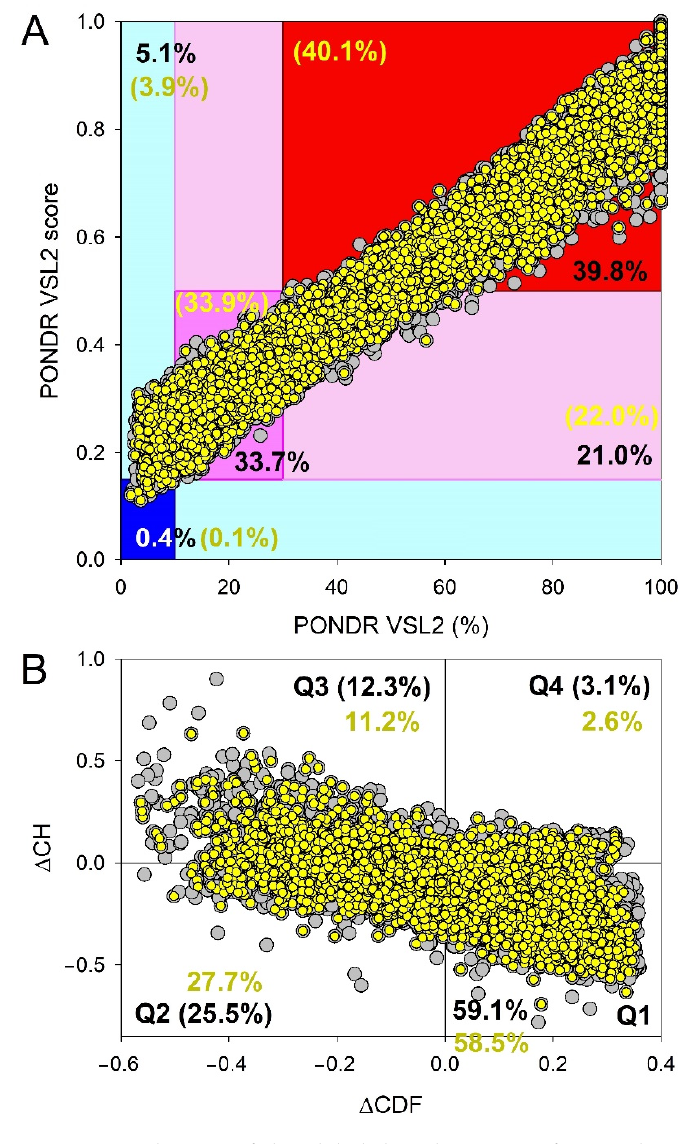
Figure 8. Evaluation of the global disorder status of 20,317 human proteins (gray circles) and 10,611 brain proteins (small yellow circles). ( A ) PONDR ® VSL2 output. ( B ) Charge ‐ hydropathy and cumulative distribution function (CH ‐ CDF) plot. For explanations, see legend to Figure 7.